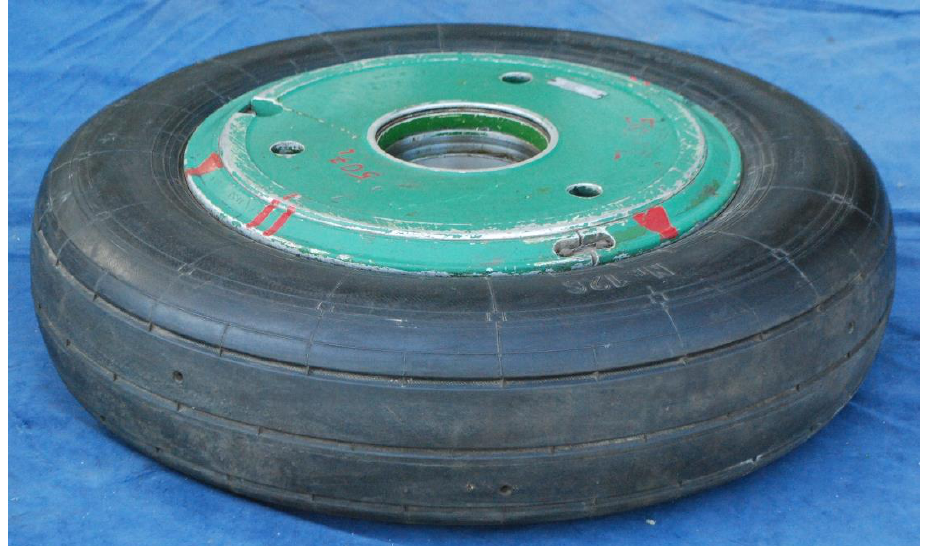
Figure 3. Su-22 tire. Figure 3. Su-22